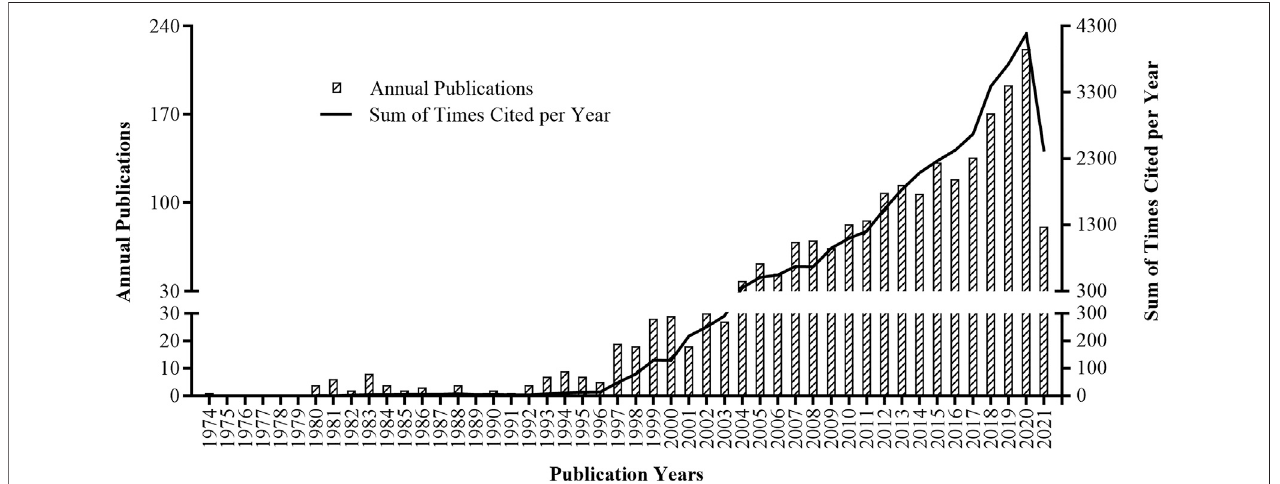
FIGURE 1 | Annual publications (column chart) and sum of times cited per year (curve line) on pharmacovigilance from 1974 to 2021.